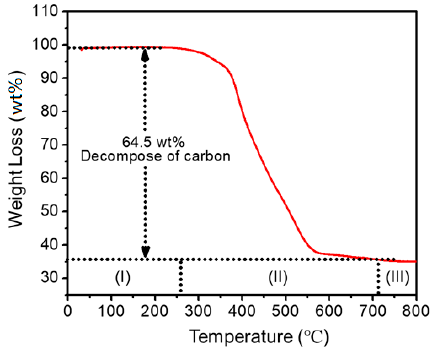
Figure 4. Thermogravimetric Analysis (TGA) curve of Co@N-C-800.